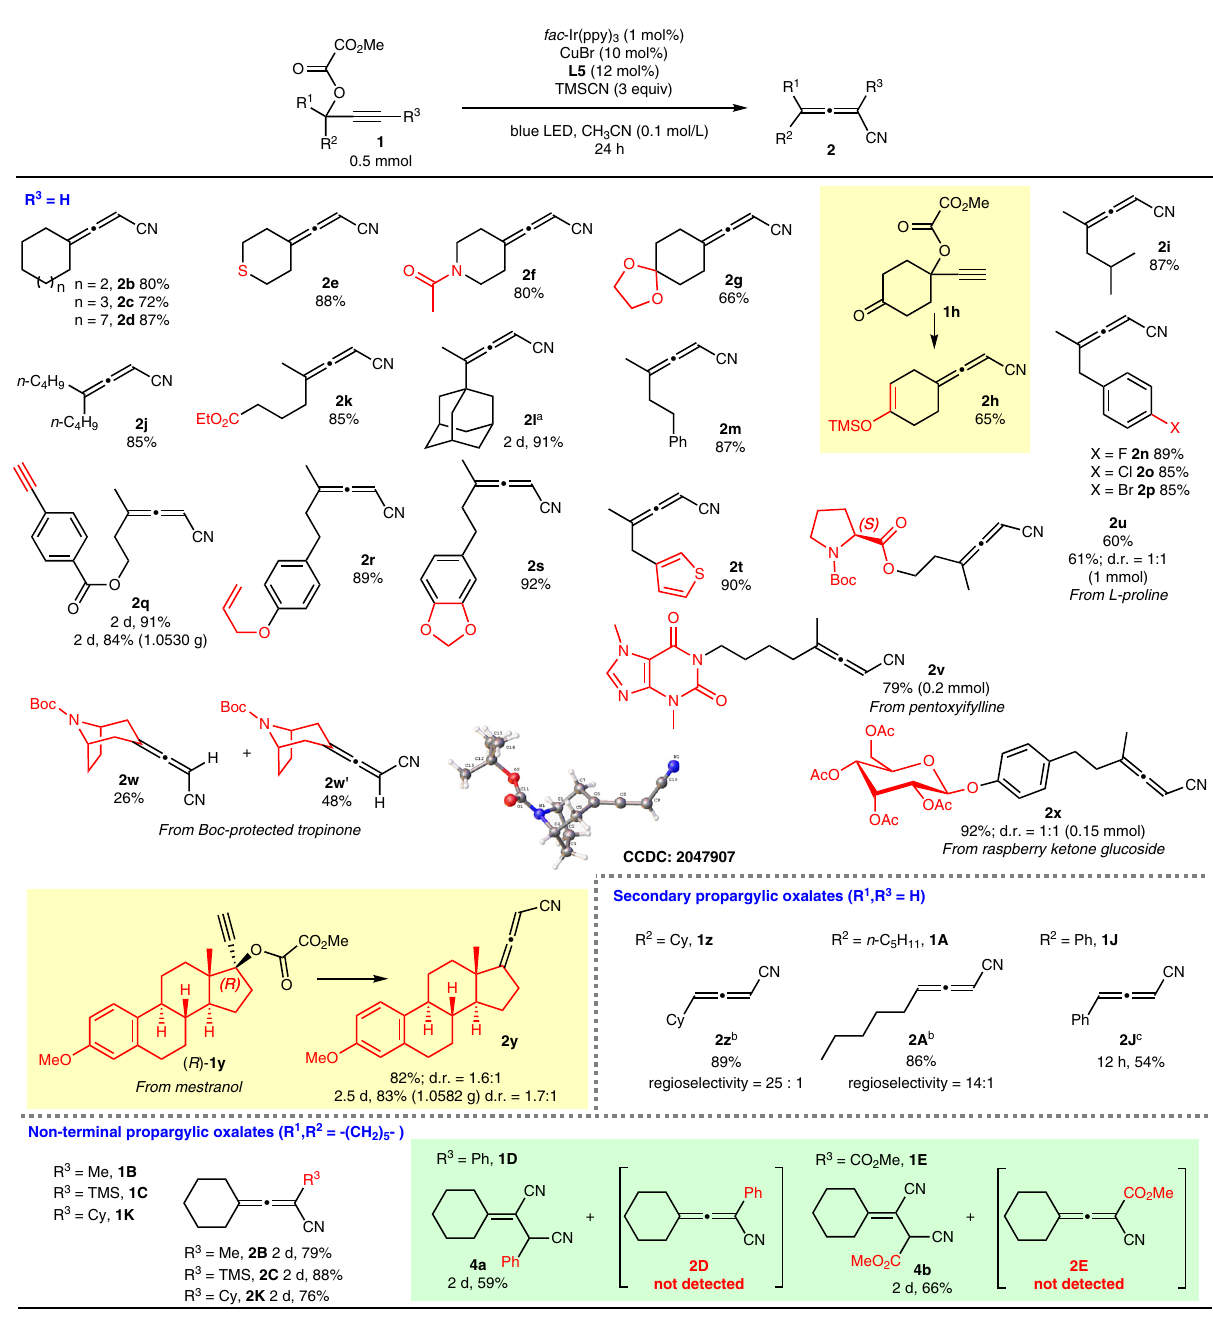
Fig. 2 Substrate scope study. a CuBr (15 mol%) and L5 (18 mol%) were used. b Due to the dif fi culty of separating the two regioisomers, the yield value refers to the isolated yield of a mixture of alkyne and allene; the regioselectivity was determined by 1 H NMR analysis. c The reaction was conducted in 10 mL CH 3